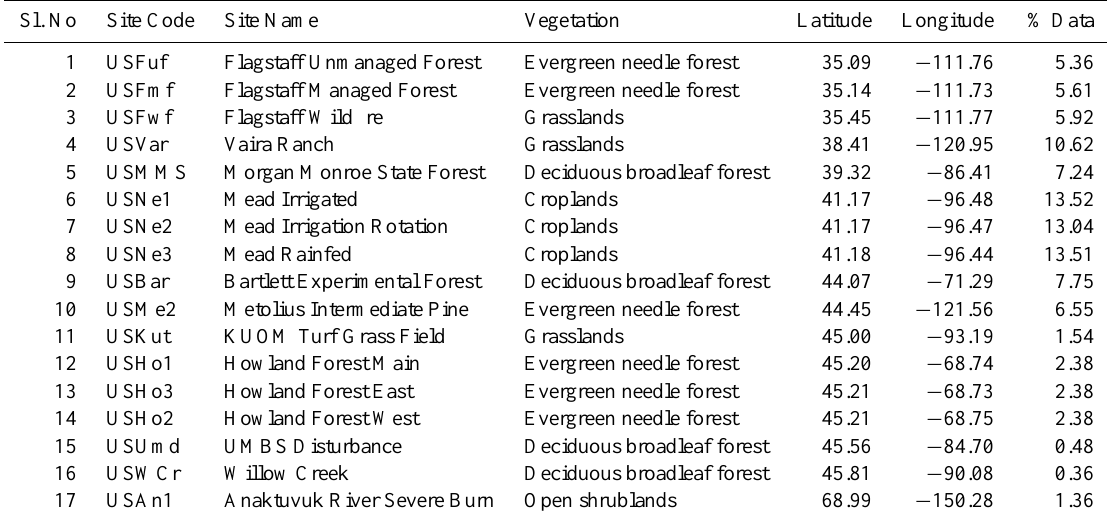
Table 1. Site location and ecosystem-type information. Sl.